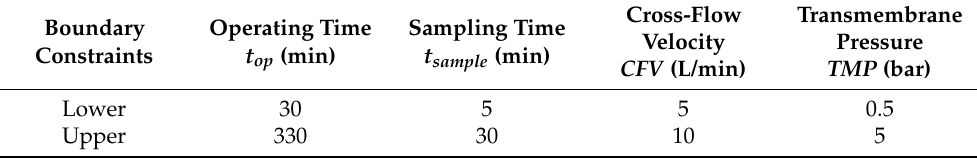
Table 2. Boundary constraints for the Genetic Algorithm optimization.